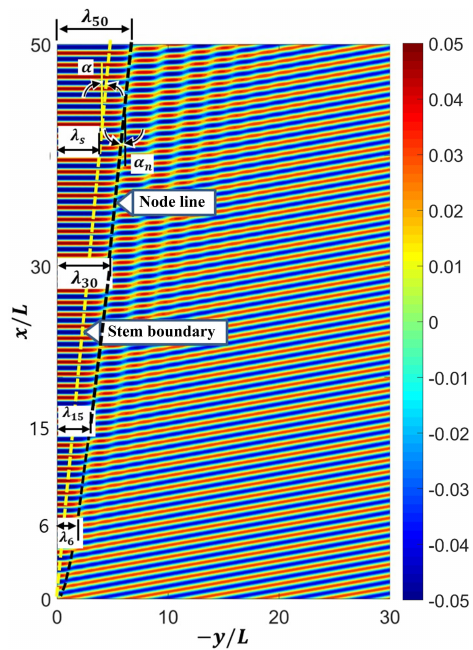
Figure 7. Definition sketch for the stem angle and the stem bound-